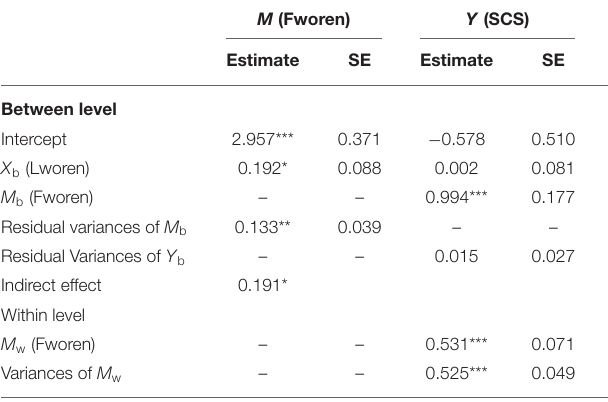
TABLE 2 | Multilevel mediation effect of followers’ work engagement. M (Fworen) Y